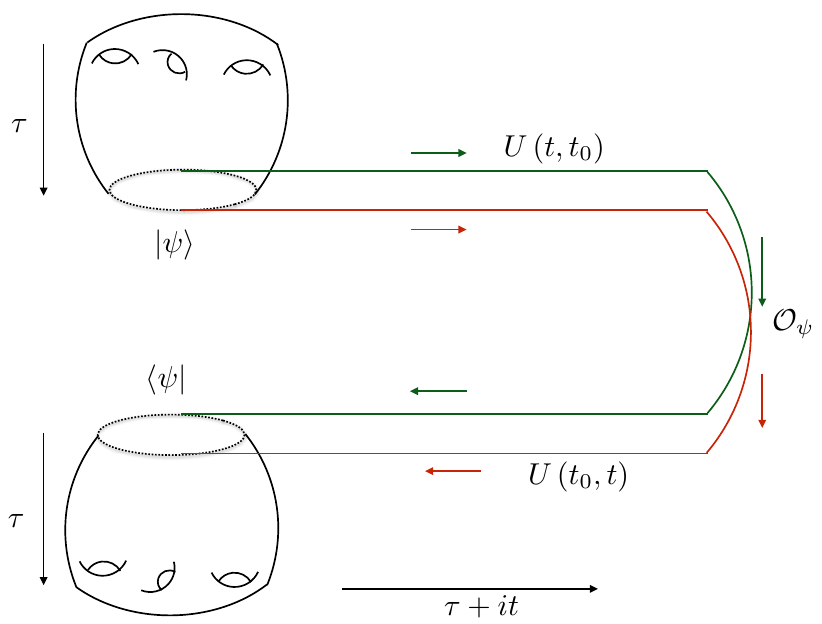
Figure 2 . A pictorial representation of gluing two arbitrary states along a Schwinger-Keldysh contour, after the insertion of an operator at real time t . The genus 3 surface in the picture is supposed to represent an arbitrary initial state. The choice of genus = 3 is simply